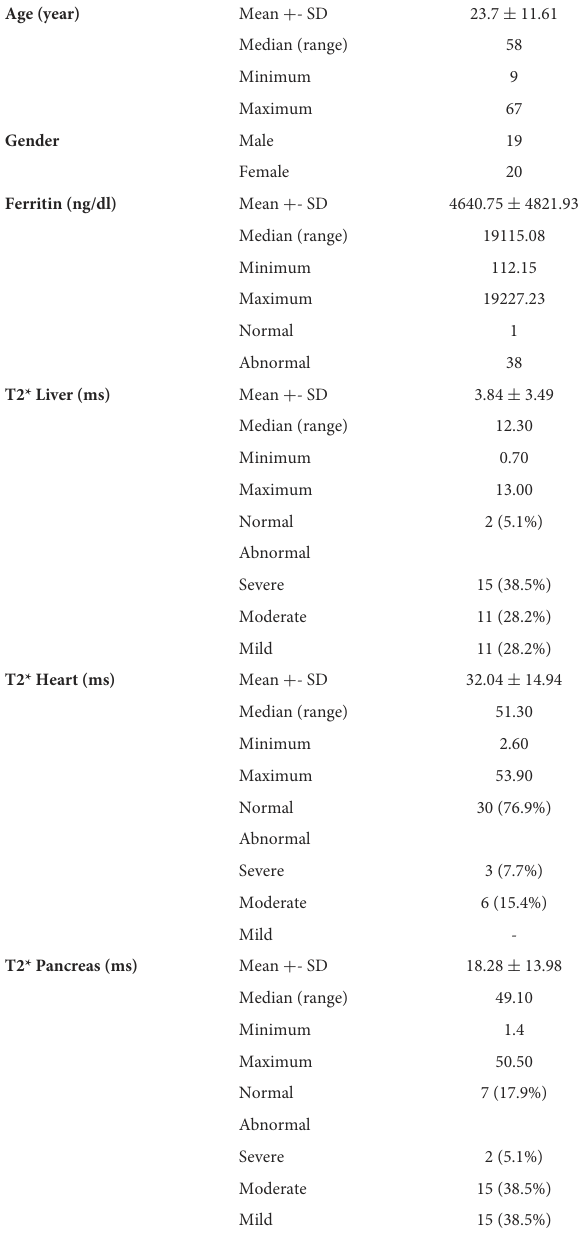
TABLE 1 Demographic data and T2* results for the